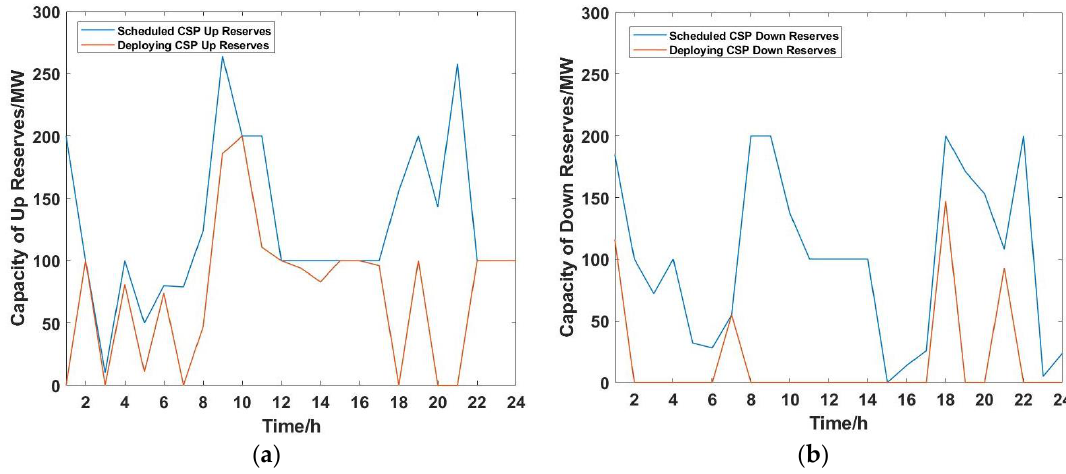
Figure 6. CSP reserve planning results at stochastic scenario 3, including: ( a ) the total scheduled up